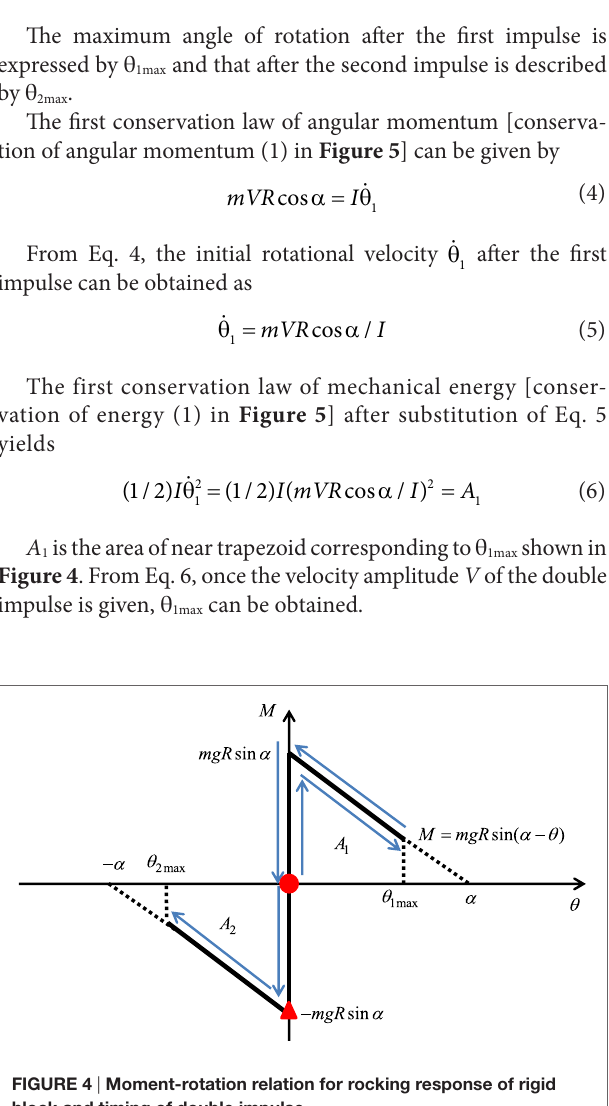
FigUre 4 | Moment-rotation relation for rocking response of rigid block and timing of double impulse .